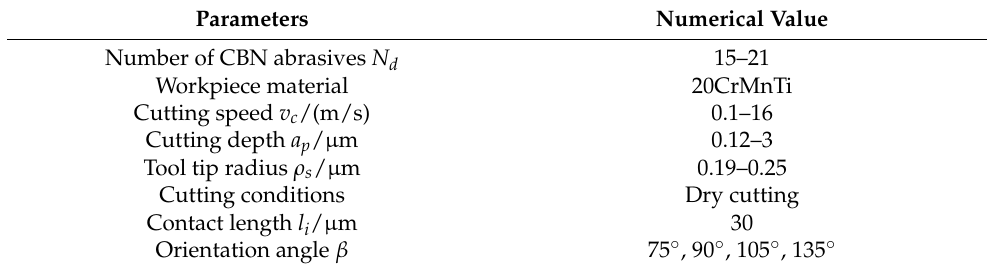
Table 1. Simulated processing